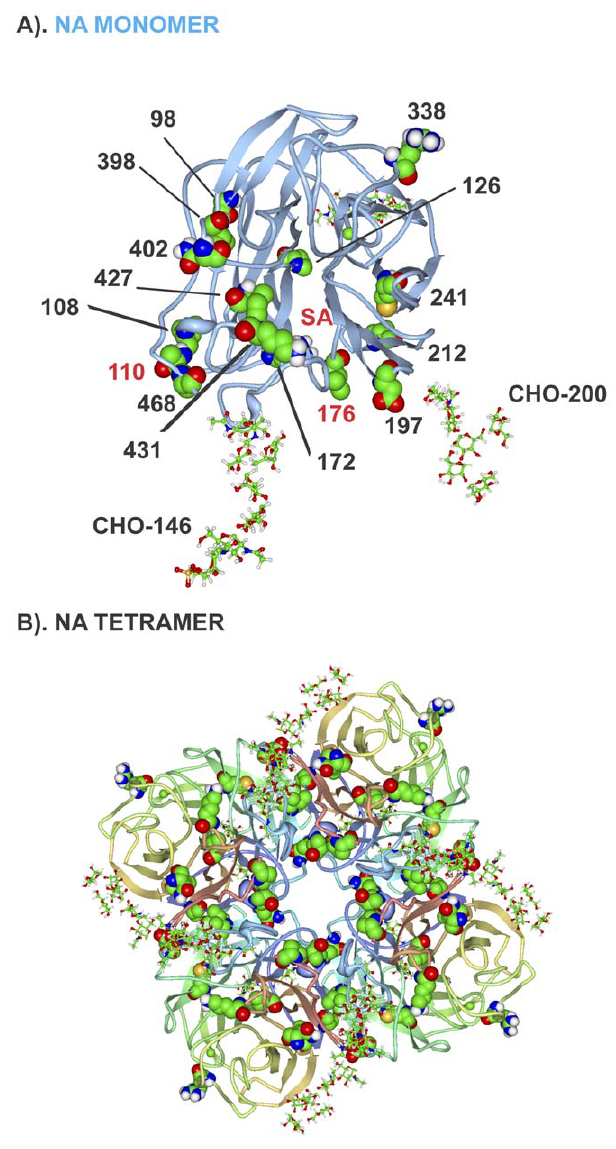
Figure 8. Mouse adaptive mutations on NA three dimensional maps. Mutations are shown as described in Fig. 3. (A) Mutations are shown in the NA monomer with receptor site indicated with SA and carbohydrate (CHO) in stick diagram; (B) the tetrameric form of NA.